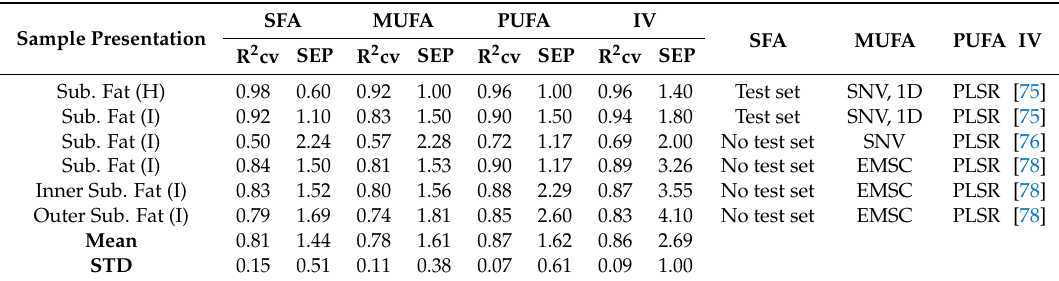
Table 4. Prediction of FA groups and IV in pork by Raman